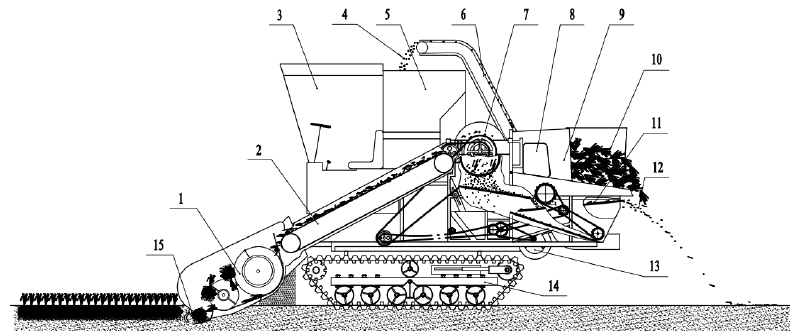
Figure 1. Structure diagram of tiger nut harvester: (1) conveying and soil-removing device; (2) scraper lifting device; (3) cab; (4) tiger nut; (5) stock bin; (6) collection and transportation device; (7) threshing device; (8) oil tank; (9) straw outlet; (10) tiger nut root; (11) cleaning device; (12) fibrous root; (13) fan; (14) crawler traveling device; (15) rotary tillage digging device.